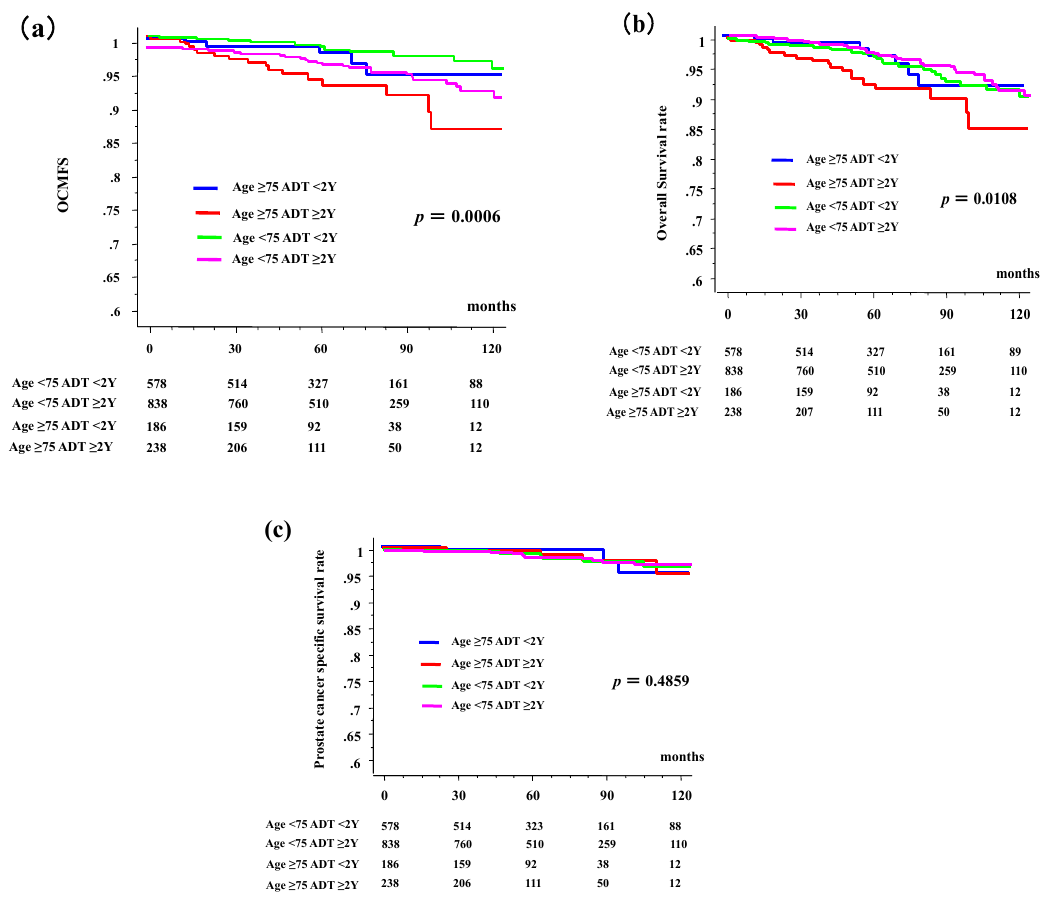
Figure 1. Other-cause of mortality (OCM), overall survival (OS), prostate cancer-specific survival, according to duration of androgen deprivation therapy (ADT) and age. ( a ) OCM-free survival rate (OCMFS). ( b ) Overall survival rate (OS). ( c ) Prostate cancer-specific survival rate. The time = 0 represents the time of start of radiotherapy.